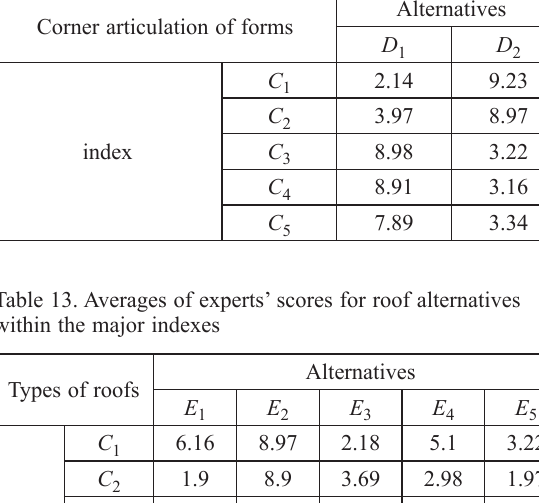
Table 14. Averages of experts’ scores for alternatives of the conformity of architecture form with the structural form within the major